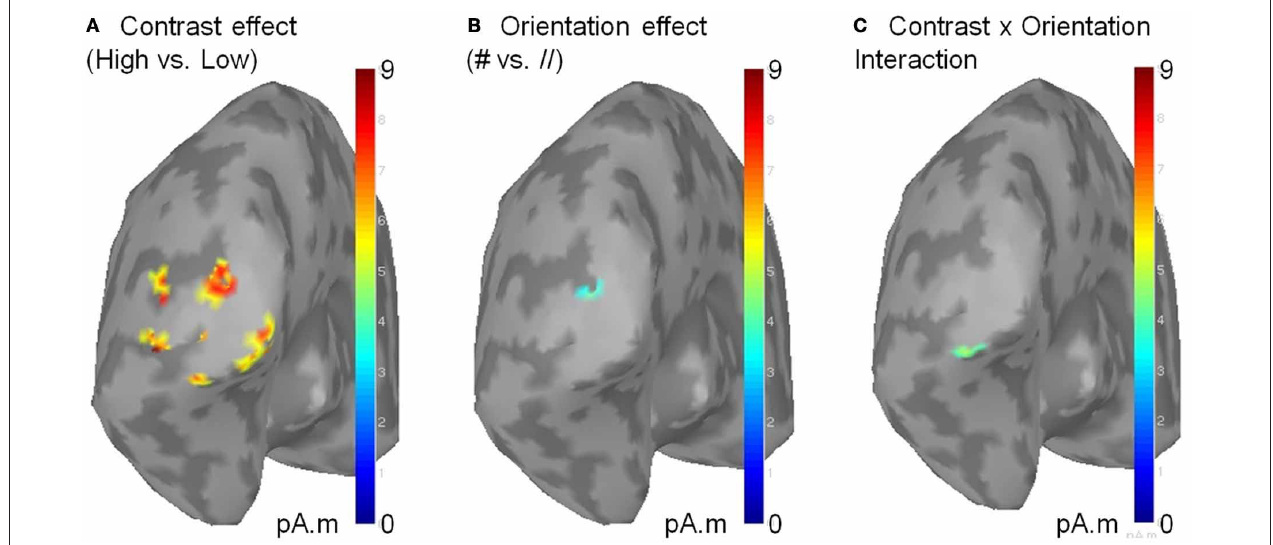
FIGURE 5 | Sources of the significant effects of contrast (A), orientation (B) and of their interaction (C). Sources were reconstructed on the MNI template using a L2minimum norm approach. Source activity was averaged on a 50ms time window centered on the response peak of each subject before averaging across subjects. Only